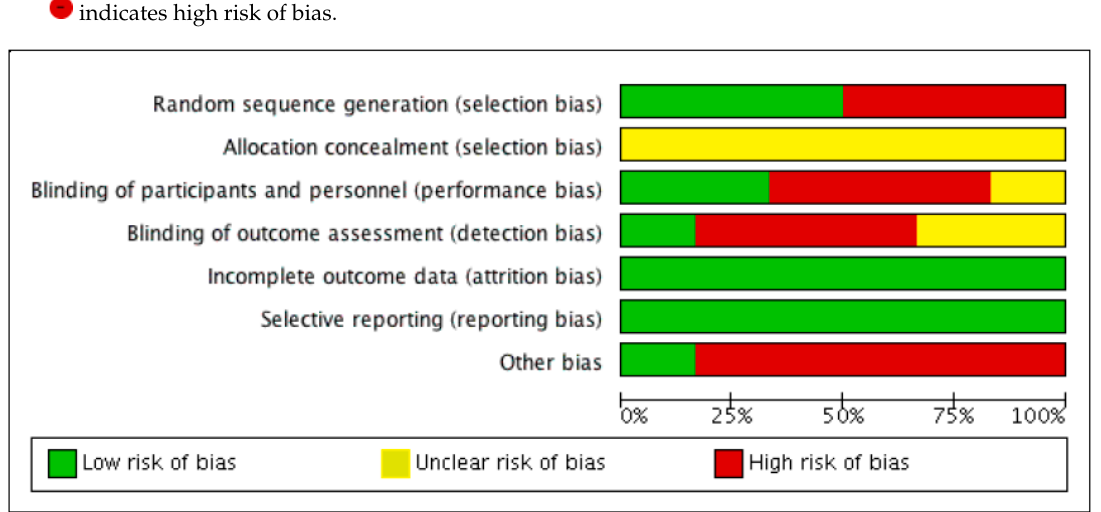
Figure 2. Risk of bias summary: review authors’ judgments about each risk of bias item for all studies.